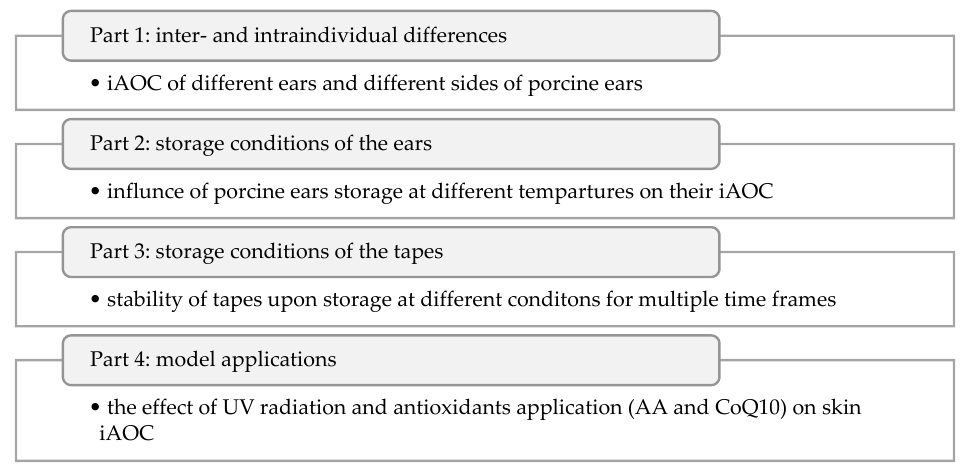
Figure 1. Study outline.